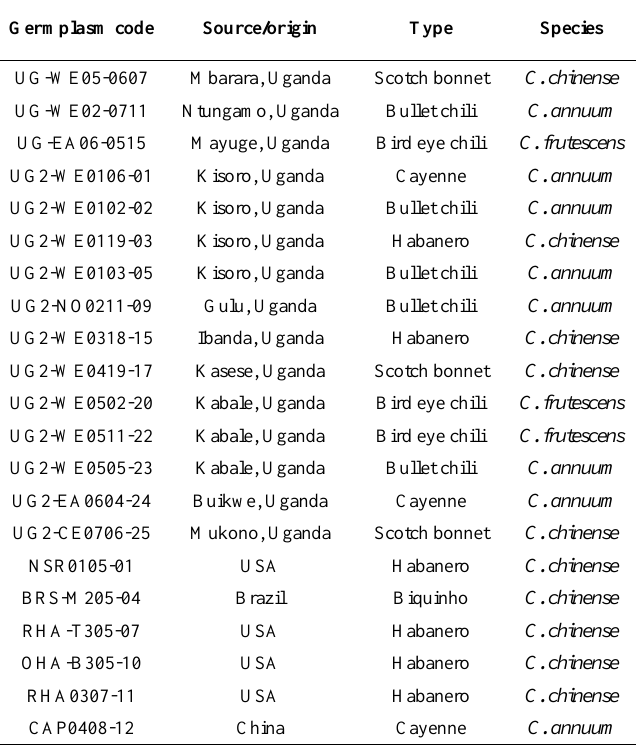
Table 1. Source, type and species of the studied Capsicum pepper genotypes Germplasm